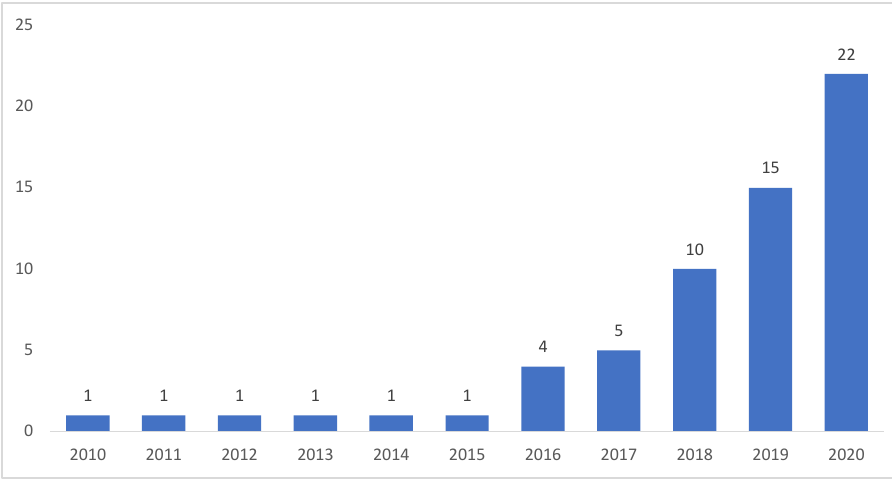
Figure 3. Number of datasets ( y -axis) divided by year ( x